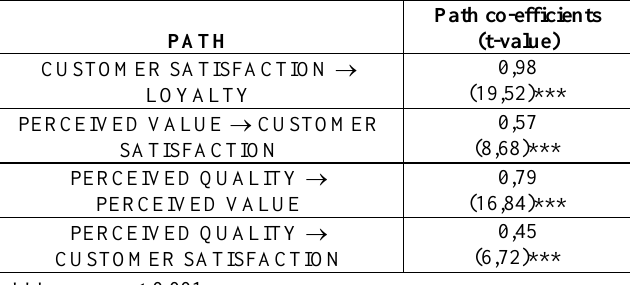
Table 4: Path co-efficients for the model in Figure